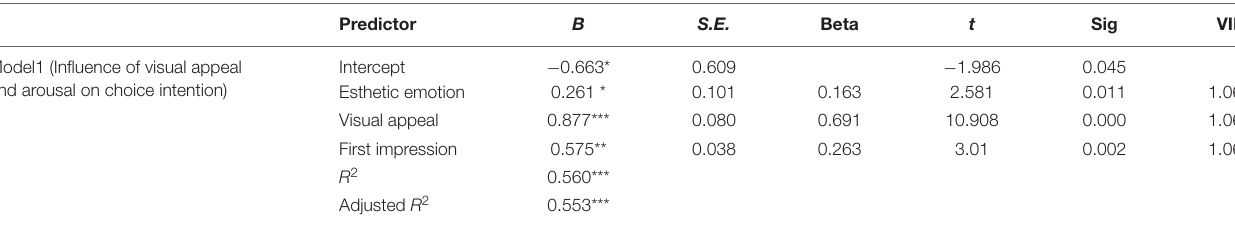
TABLE 5 | Multiple linear